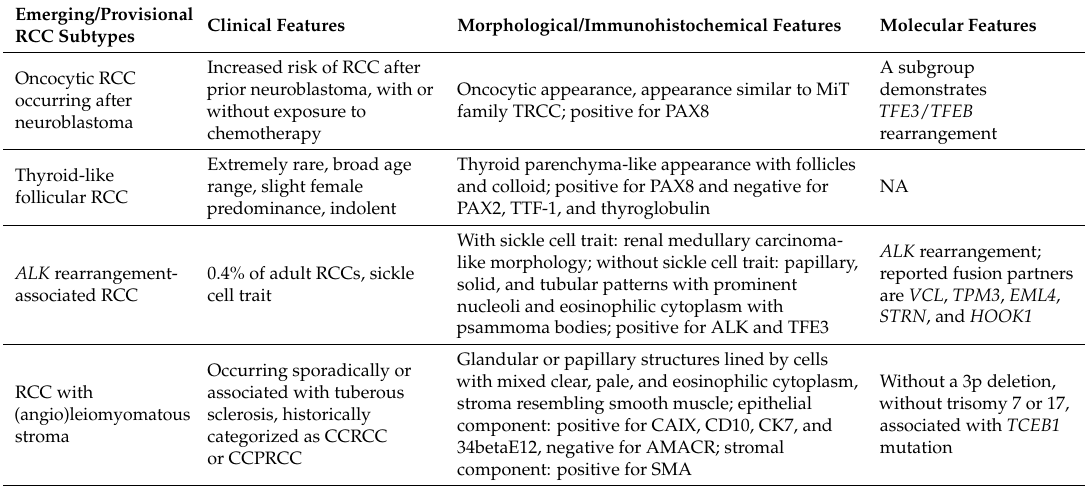
Table 4. Emerging/provisional entities of RCCs in the 2016 WHO classification